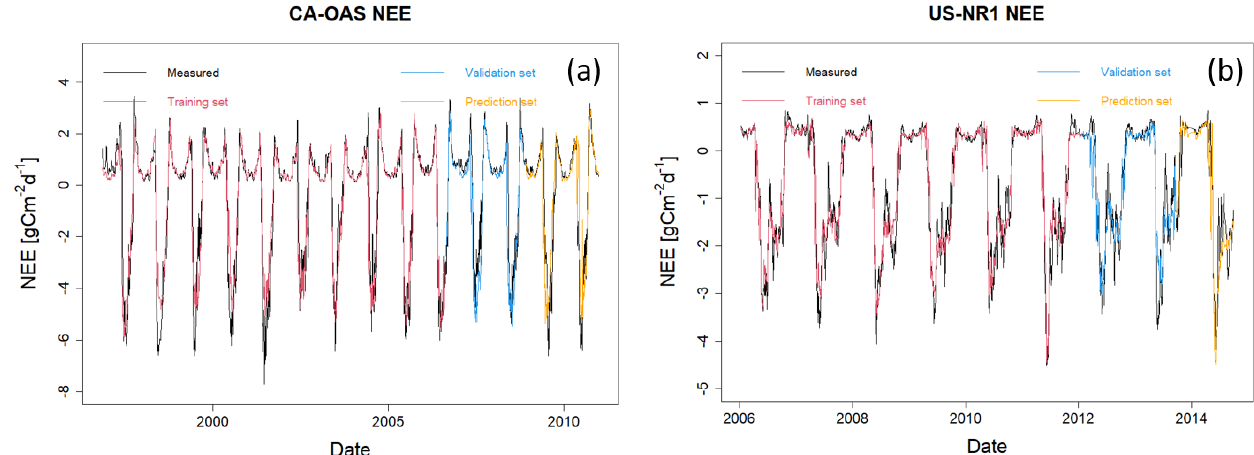
Figure B1. HPM estimate of NEE at CA-OAS and US-NR1. R 2 values between estimation and measurements are 0.87, 0.83, and 0.81 at CA-OAS and 0.94, 0.88, and 0.90 at US-NR1 for the training set, validation set, and prediction set, respectively. Model inputs include air temperature, soil temperature, sn, precipitation, and